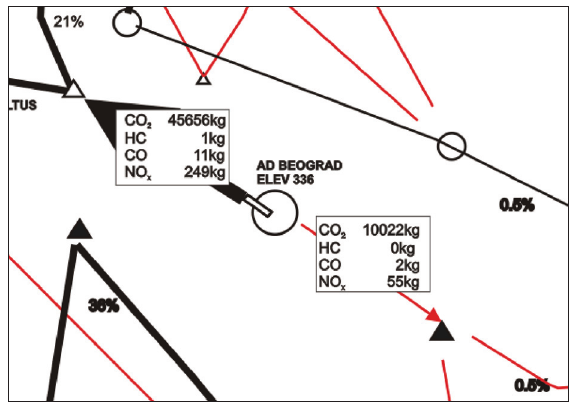
Fig. 2. The distribution of emissions during departure on an average summer day of